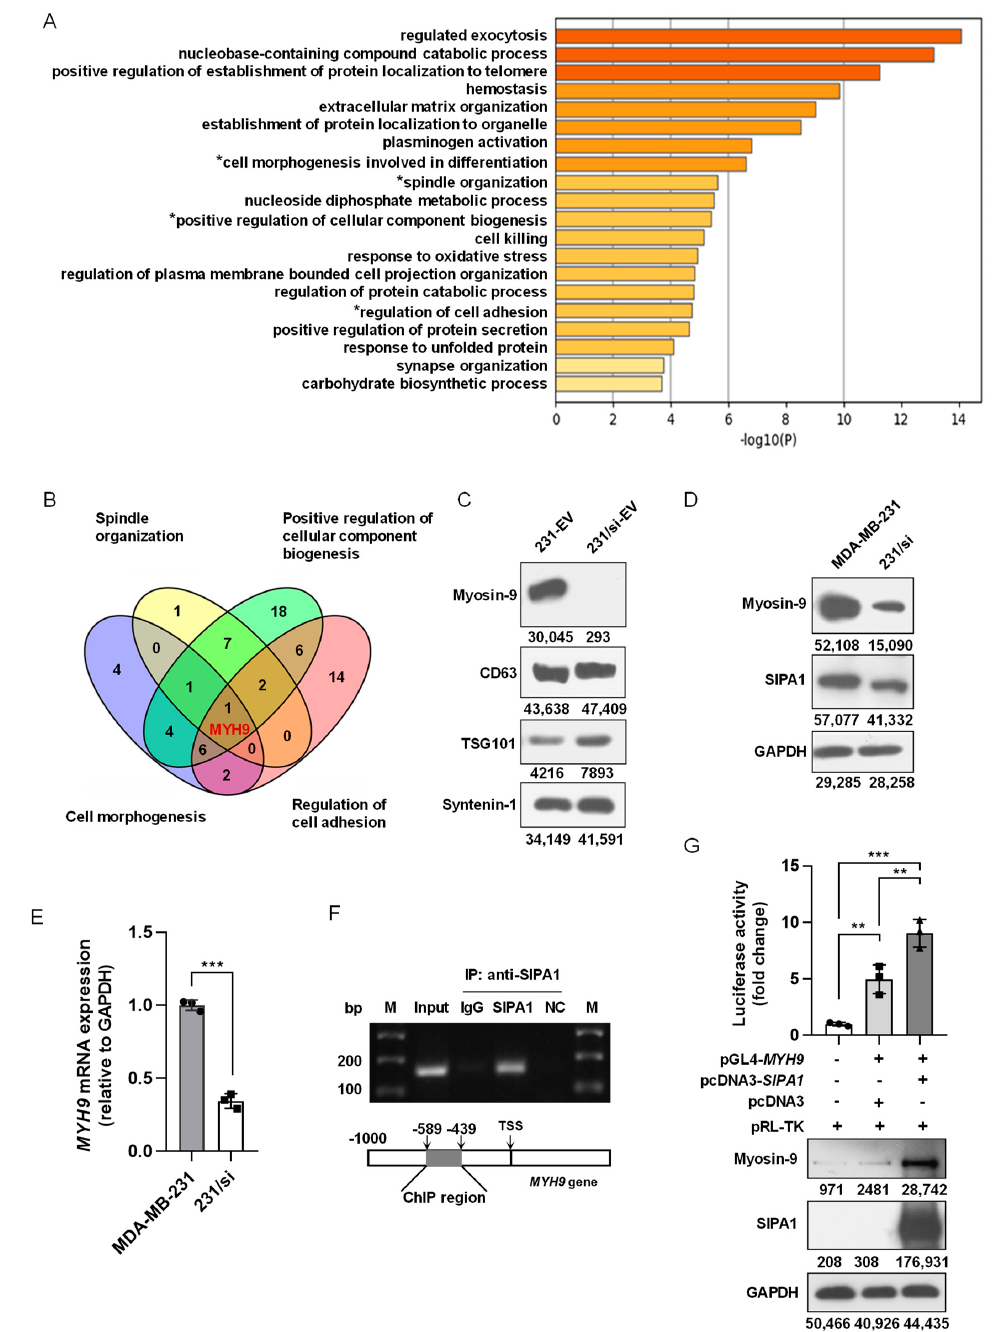
Figure 4. SIPA1 upregulates MYH9 expression in breast cancer cells and facilitates the accumulation of myosin-9 in EVs. ( A ) Gene ontology (GO) analysis of 158 protein candidates exclusively in 231-EVs. The top twenty terms in the GO analysis are depicted as a bar graph. ( B ) Venn diagram of the four GO terms related to cell motility. ( C ) Detection of myosin-9, CD63, TSG101, and syntenin-1 by Western blotting in EVs. ( D ) Detection of myosin-9 and SIPA1 by Western blotting in MDA-MB-231 and 231/si cells. ( E ) Detection of MYH9 mRNA levels in MDA-MB-231 and 231/si cells by qRT-PCR (n = 3); *** p < 0.001. ( F ) Chromatin immunoprecipitation (ChIP) PCR analyses for the interaction between SIPA1 and the MYH9 promoter region. NC: Negative controls. M: DNA marker ladders. ( G ) The MYH9 promoter activity measurement by dual-luciferase reporter assay in HEK293T cells (upper panel, n = 3), and the expression detection of SIPA1 and myosin-9 by Western blotting (lower panel); ** p < 0.01; *** p <